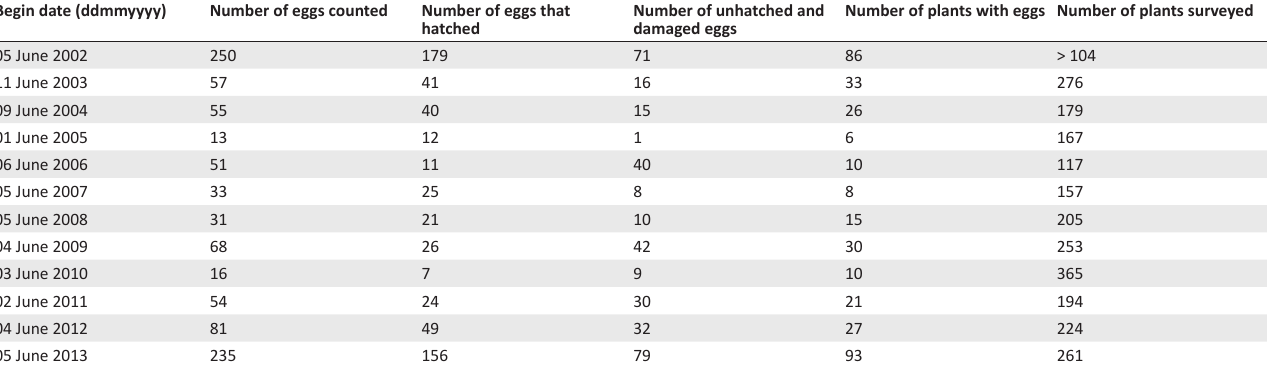
TABLE 3: Number and fate of Orachrysops ariadne eggs, number of Indigofera woodii var. laxa host plants with eggs, number of host plants surveyed, and standardisation of the number of eggs at the Nkandla monitoring site.